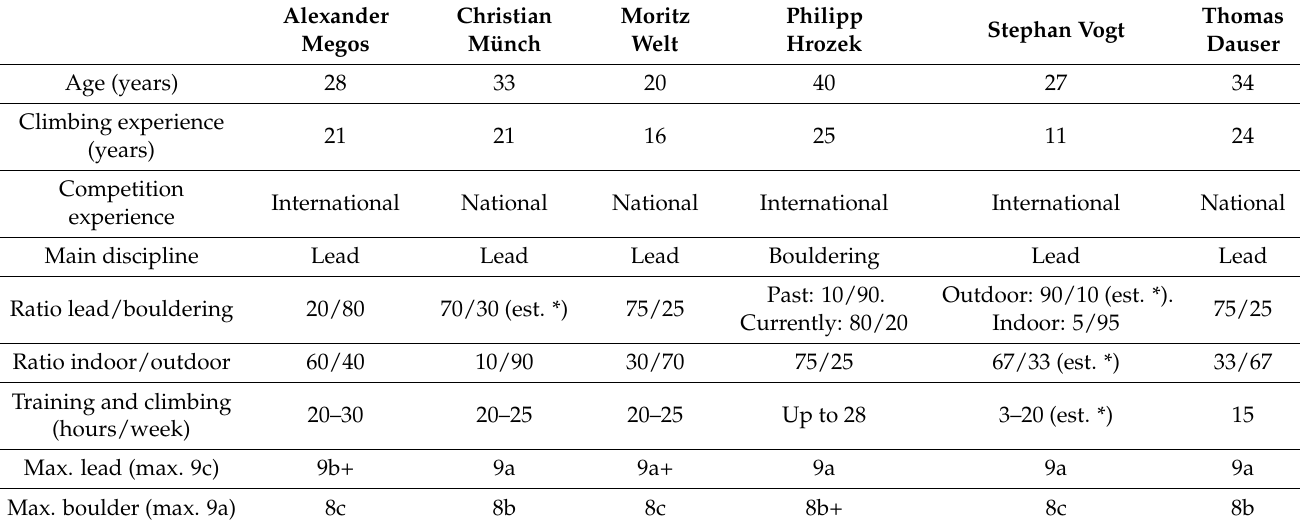
Table 1. Participant profiles as suggested by IRCRA